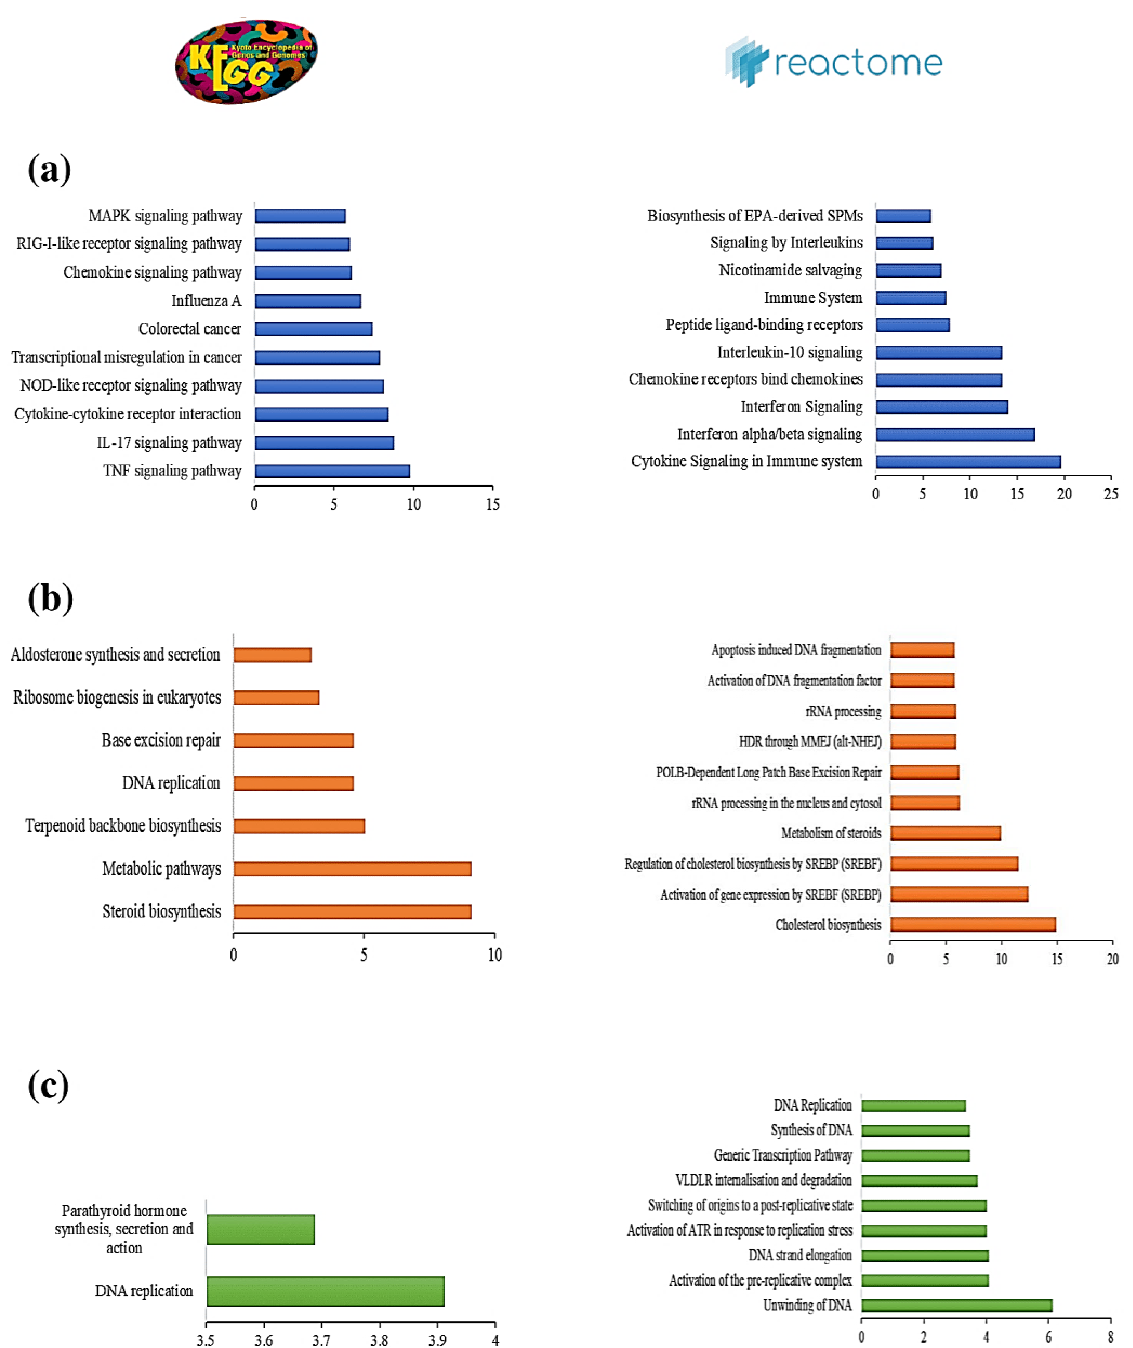
Figure 5. The ten most-highly enriched KEGG and Reactome pathways in the ( a ) blue, ( b ) brown, and ( c ) turquoise modules.